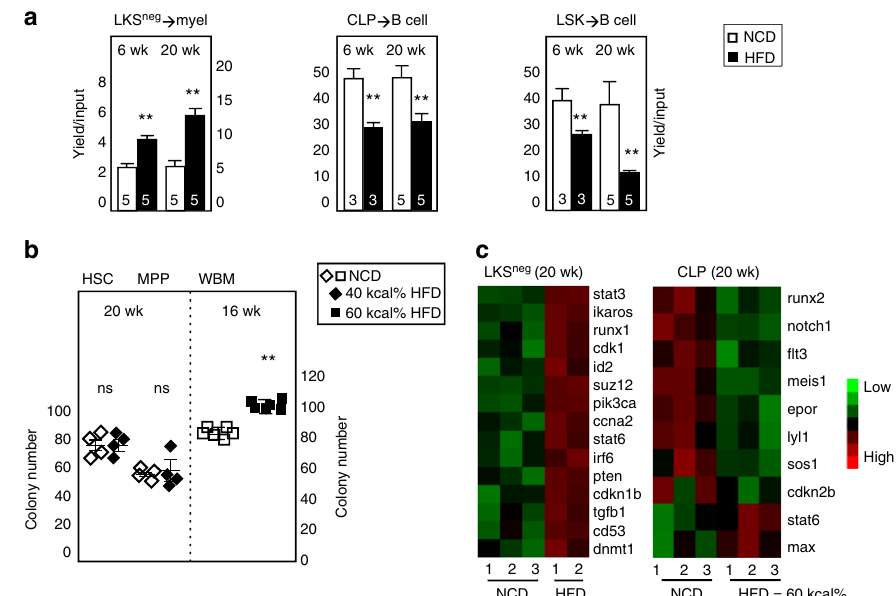
Fig. 2 BM LKS neg and CLP functional defects emerge early in obesity. a B6 mice were fed the indicated high-fat or nutrient-matched control diet for 6 or 20 weeks, after which de fi ned BM precursor subsets were sorted for analysis of differentiation potential under stroma-free, serum-free conditions. lineage − c-kit + Sca-1 − (LKS neg ), common lymphoid progenitor (CLP) and LSK subsets were assays in liquid cultures under myeloid- or lymphoid-supportive conditions for 8 or 12 days, respectively, after which cells were stained with antibodies to CD19, B220, Gr-1, or CD11b. Yield/cells input is shown. Bar graphs depict average ± SEM of data from two independent experiments of NCD/HFD mice assayed in parallel, with the total number of mice inset. b Sorted HSC (CD150 + fl k2 − LSK), MPP ( fl k2 + LSK), each at 100 cells per well, or 2 × 10 4 BM cells (WBM) from NCD or HFD mice were cultured in Methocult and colonies enumerated on day 10. For scatter plots, data are pooled from three independent experiments of paired NCD/HFD mice. Each symbol is an individual animal. Bar graphs depict average ± SEM (duplicate experiments, total n = 4/group). a – b Data are analyzed by Student ’ s t -test with Bonferroni correction for multiple comparisons. Error bars represent s.e.m. ** p < 0.05; ns, not signi fi cant. c NanoString expression analysis of canonical genes associated with lymphoid or myeloid potential in BM LKS neg and CLP progenitors sorted from mice fed high-fat or control diet for 20 weeks. Each lane is a different mouse; one lane was lost due to an instrument technical colonies relative to NCD animals, con fi rming past reports 12,13 (Fig. 2b & Supplementary Figure 1E). No differences in colony size were detected (Supplementary Figure 1E). We then examined the RNA expression pro fi les of LKS neg and CLP subsets isolated genes associated with lympho-myeloid differentiation, signal validated and extended by RT-QPCR (Supplementary Figure 2B).